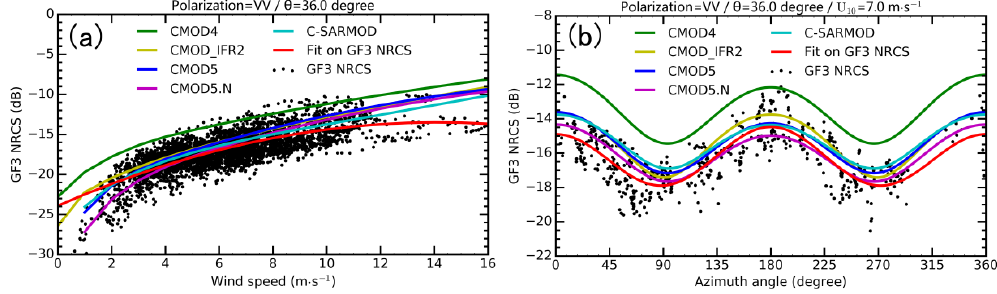
Figure 5. The GF-3 NRCS of VV polarization as a function of ( a ) wind speed and ( b ) azimuth angle. The GF-3 NRCS data are fitted and compared to GMFs including CMOD4, CMOD_IFR2, CMOD5, CMOD5.N, and